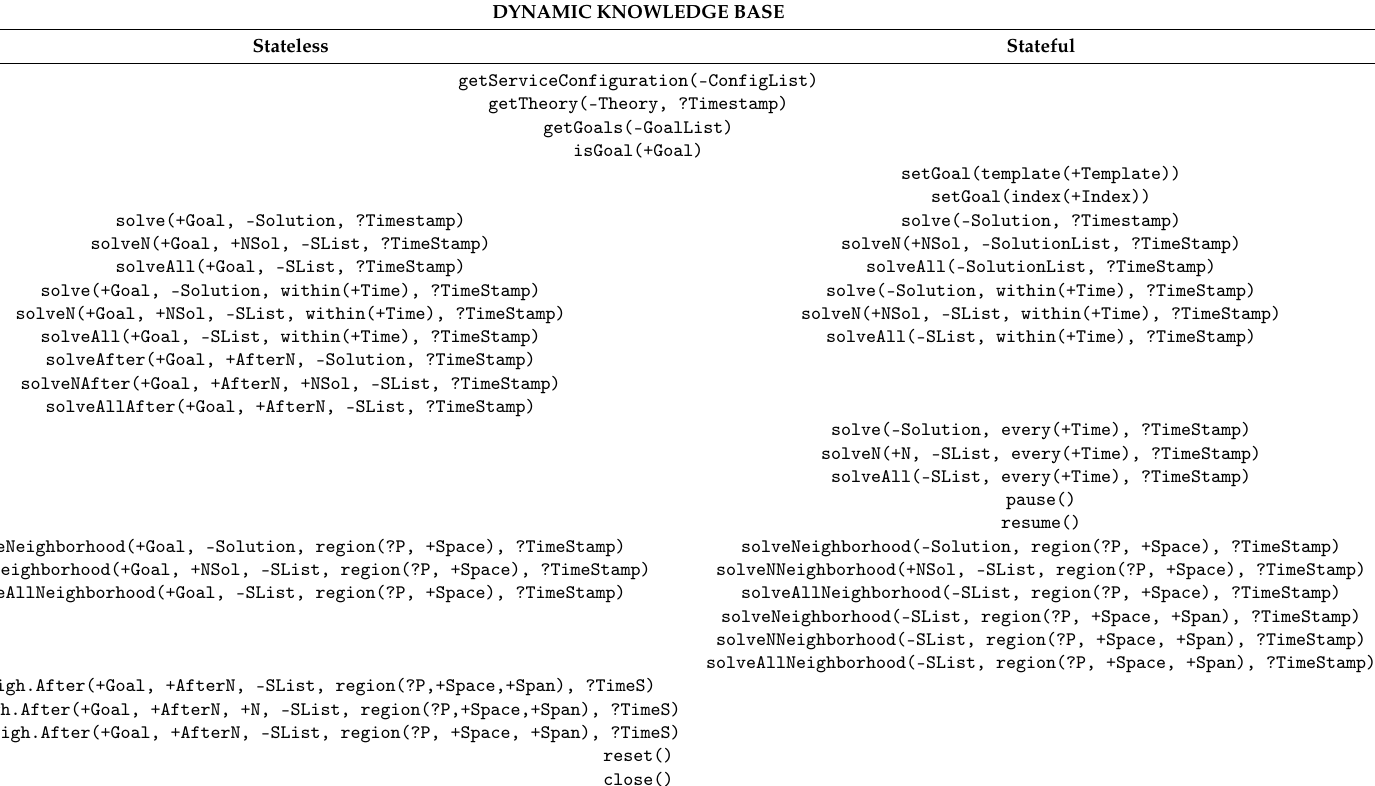
Table 2. LPaaS client